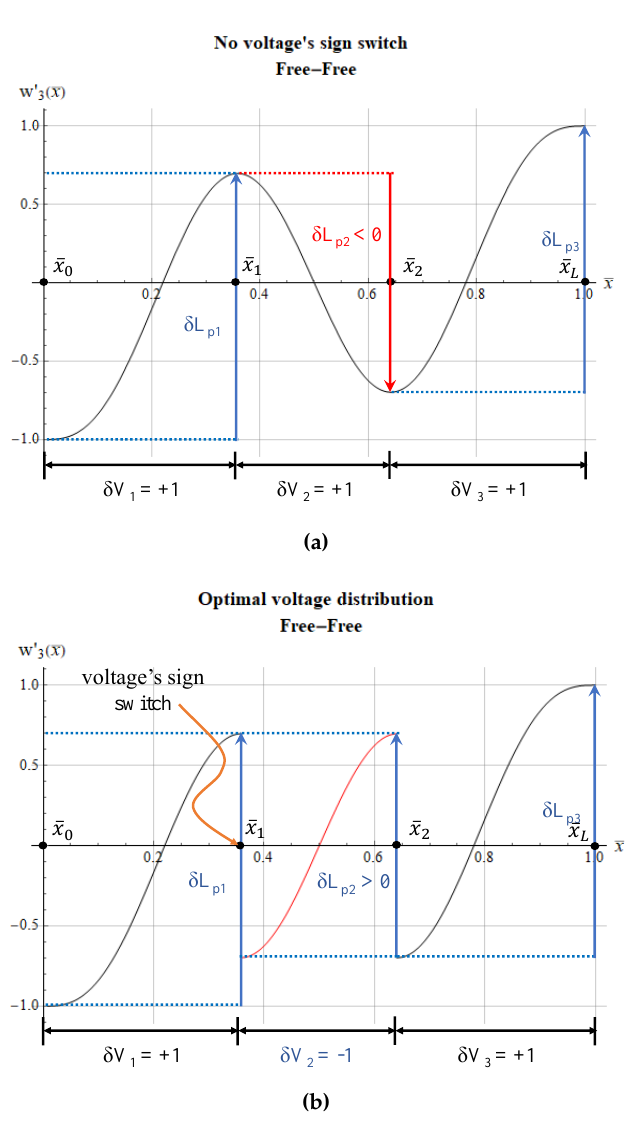
Figure 4. Example of the optimal voltage distribution to achieve the maximum work δ L p for the third mode and free-free boundary condition. δ L p is only dependent on the first derivative of the ( ¯ x ) ): ( a ) no voltage’s sign switch is provided, ( b ) optimal voltage distribution (two eigenmode ( w (cid:48) 3 sign switches entailed). In the case ( a ), the total work δ L p = δ L p 1 + δ L p 2 + δ L p 3 is not the highest since the work δ L p 2 is negative and reduces the total work. Case ( b ) shows that the optimal voltage distribution entails two voltage sign switches, respectively, at ¯ x 1 = 0.36 and ¯ x 2 = 0.64. In this way, the resulting total work δ L max p = δ L p 1 + δ L p 2 + δ L p 3 is the highest since δ L p 2 is actually positive. The ( ¯ x ) when the voltage’s sign is switched for 0.36 ≤ ¯ x ≤ solid red line represents the function w (cid:48) 3